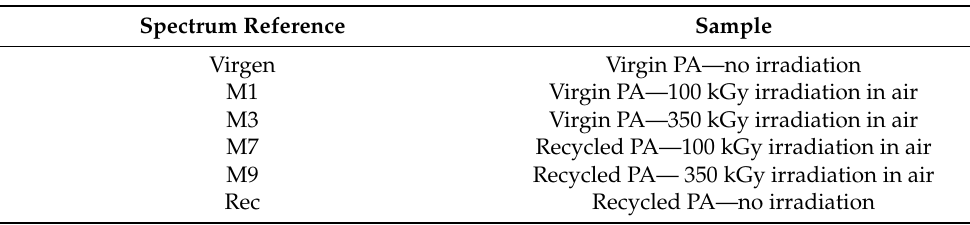
Figure 9. EPR spectra obtained for samples without and with irradiation at different absorbed doses. Scan in magnetic field: 345–355 mT.